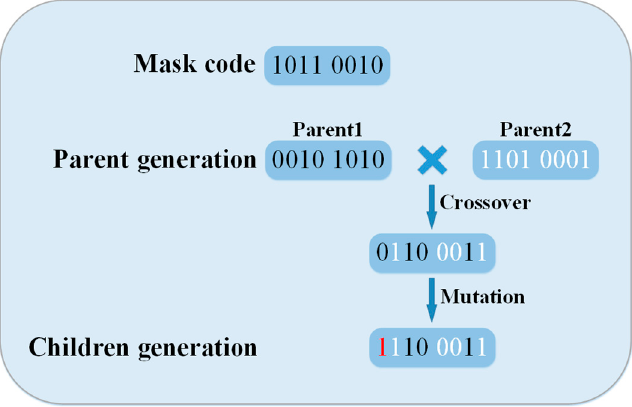
Figure 7. Schematic of crossover and mutation.